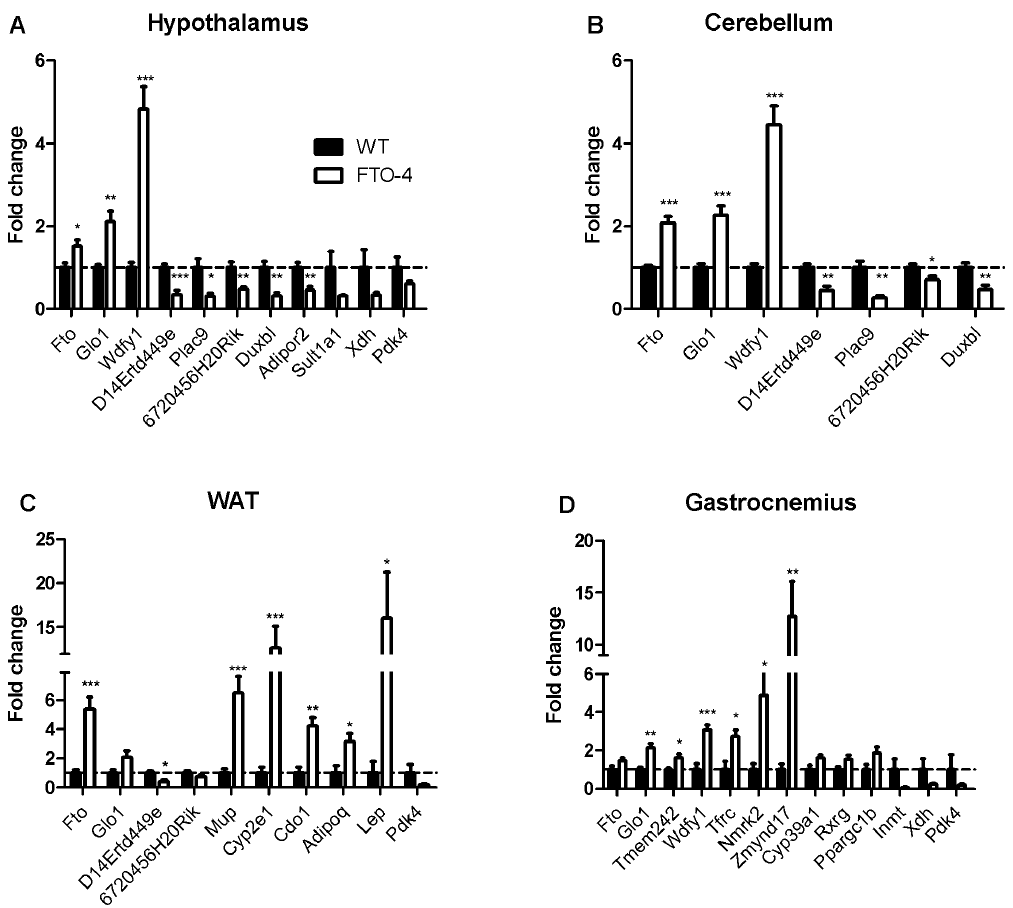
Figure 2. Differences in gene expression between WT and FTO-4 mice based on microarray data. Expression of the indicated genes in the cerebellum (A), hypothalamus (B), WAT (C) and gastrocnemius (D) of wildtype (WT, black bars) and FTO-4 (white bars) mice. Data are expressed as the fold change compared to wildtype. Significance was tested using Student’s t-test to compare FTO-4 to WT. ***p , 0.001, **p , 0.01, *p , 0.05.